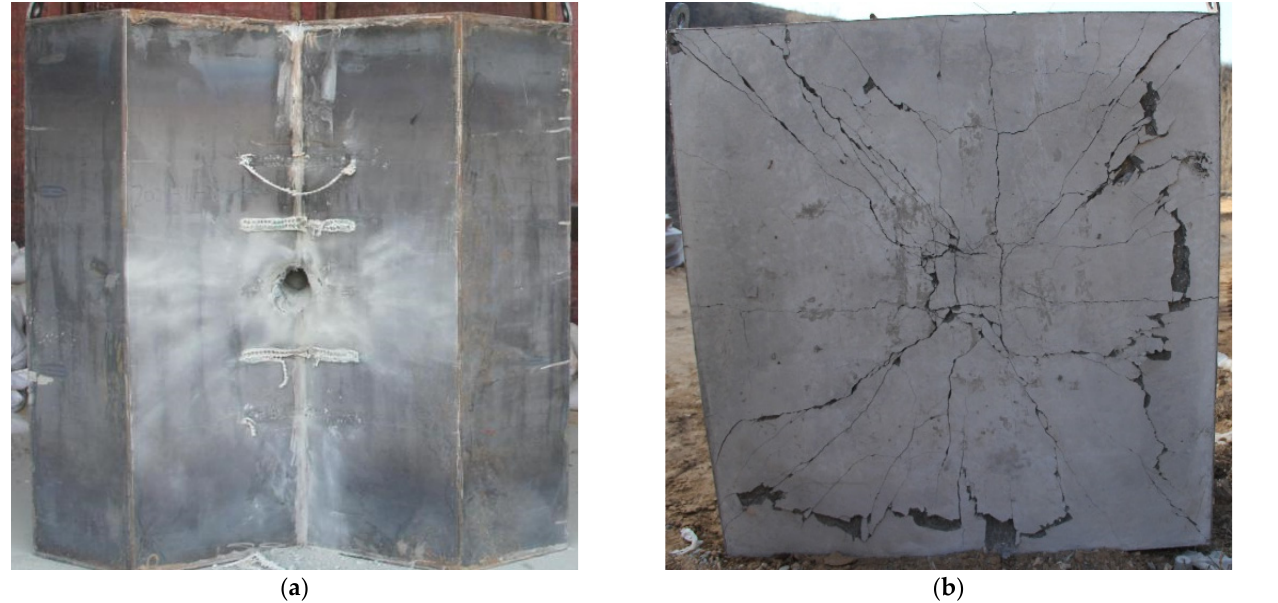
Figure 13. Photographs of the target plate after impact (with diamond-shaped moving target, Test 3). ( a ) Front side. ( b ) Back side.